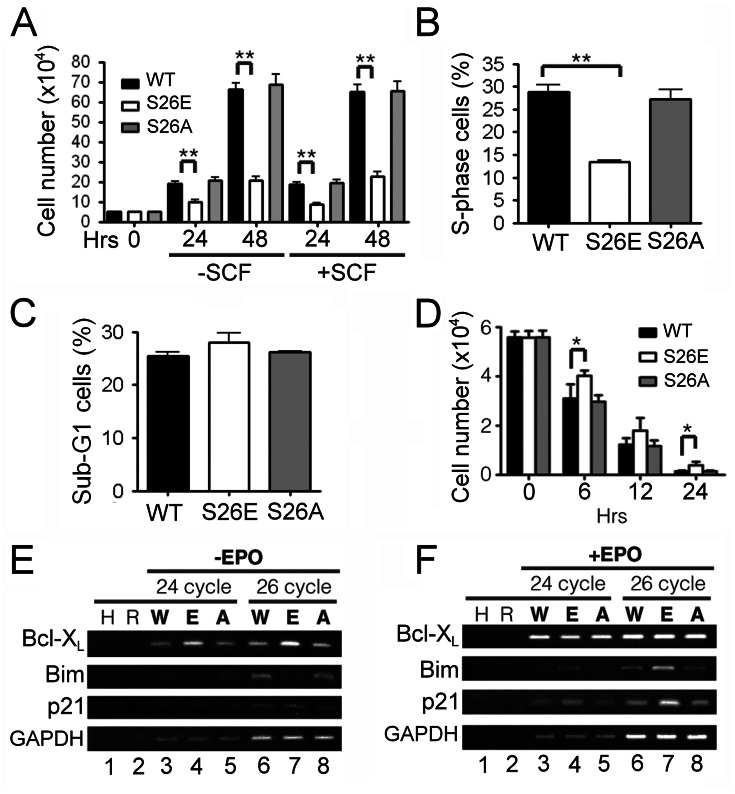
Differential responses of GATA-1S26E EPs in medium with or without EPO.(A-C) Impaired growth of GATA-1S26E EPs in medium containing EPO. (A) Purified EP cells with the indicated genotype were cultured in medium containing EPO plus the presence or absence of SCF and the viable cell numbers at various time points were determined. (B,C) Same as in (A) in culture without SCF except that the percentage of cells in S phase (B) or with sub-G1 amount of DNA (C) after 24 hr’s culturing was analyzed by flow cytometry (see Materials and Methods). (See also Figure S3 for one representative contour plot of the flow cytometric analysis shown in panels B and C). (D) Survival advantage of GATA-1S26E EPs in medium without EPO. Purified EP cells were cultured in medium without EPO and viable cell numbers at various time points were determined. All results shown in panels A-D are mean ± SD (n = 3–6 for each genotype). (E) Analysis of mRNA expression of genes related to cell growth and/or survival by RT-PCR. Purified EPs with the indicated genotype were cultured in medium without (E) or with (F) EPO for 6 hours, and mRNA expression levels of the indicated genes were analyzed by semi-quantitative RT-PCR analysis (24 or 26 cycles). H and R are negative controls using water or without RT, respectively, in the analysis buffer. W,E and A denote RNA from control, GATA-1S26E and GATA-1S26EA EPs, respectively. P21, p21Waf1/Cip1. Both (E) and (F) are one representative data set from 3 independent experiments with very similar results (see Figure S4 for quantification of these results). *, P<0.05; **, P<0.01.